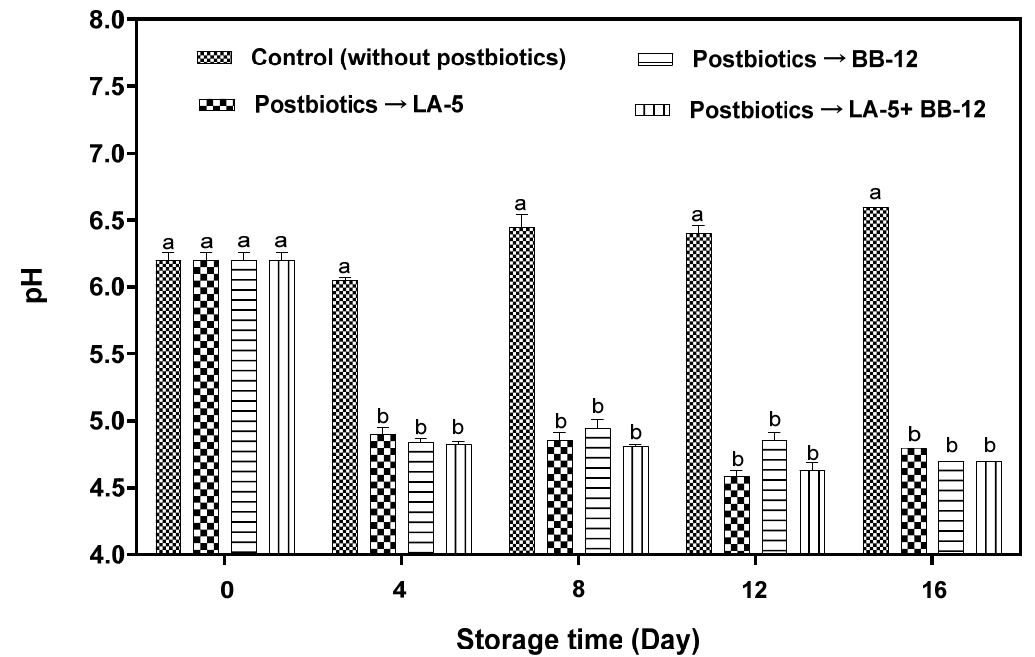
Figure 2. pH changes in mozzarella cheeses preserved in postbiotic solutions from L. acidophilus LA-5 (P-LA-5), B. animalis BB-12 (P-BB-12), and their combination (P-LA-5 + BB-12) during storage at 7 °C. Different lowercase letters indicate a significant ( p < 0.05) difference between treatments on each storage day.